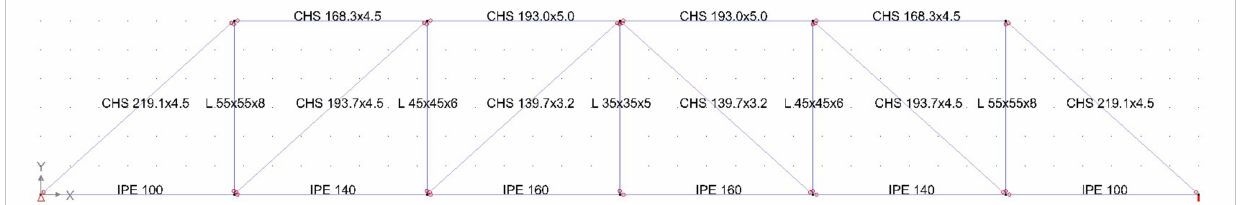
Figure 7. Warren truss, span L = 40 m, height H = 7 m, number of panels n = 5, optimal standard sections are indicated.